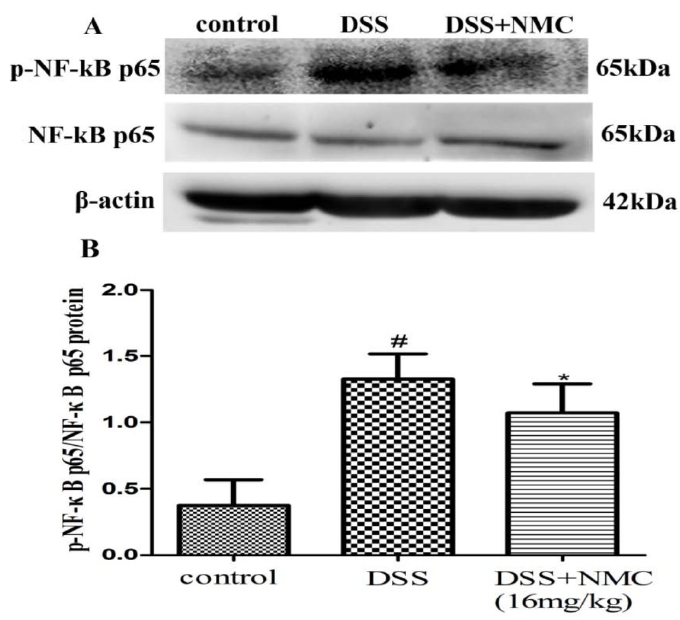
Figure 8. Effects of NMC on the expression of p-NF-kB p65 and NF-kB p65 in DSS-induced colitis. ( A ) The expression of p-NF-kB p65 and NF-kB p65 in colon tissue were determined using Western blotting. ( B ) The relative quantification of p-NF-kB p65 and NF-kB p65 protein expression calculated by using Image J software. Data are expressed as mean ( n = 10 per group) ± SEM. # p < 0.05 compared with control group; * p < 0.05 compared with the DSS-vehicle group.